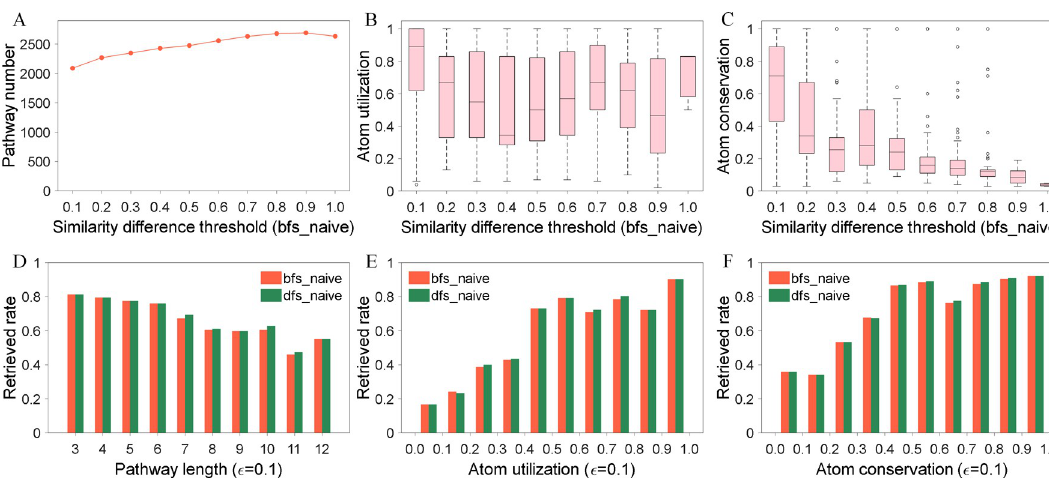
Fig 5. Relationships between the search results of metabolic pathways in the validation set and the pivotal parameters of PyMiner, including similarity difference threshold, pathway length, atom utilization and conservation. (A) The effect of similarity difference threshold ε on the number of retrieved pathways. (B) The effect of similarity difference threshold ε on the atom utilization of initial substrate. (C) The effect of similarity difference threshold ε on the atom conservation of target product. (D) The relationship between pathway length and the retrieved rate. (E) The relationship between the atom utilization of initial substrate and the retrieved rate. (F) The relationship between the atom conservation of target product and the retrieved rate. Bfs_naive indicates breadth-first search method. Dfs_naive denotes depth-first search method. Due to the constraints of maximum search time and computing resources, the search results of two methods show slight differences.